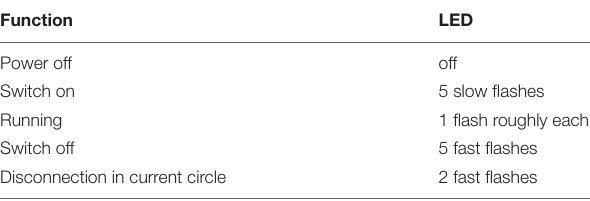
TABLE 1 | Flash-code of the white LED on the circuit board.